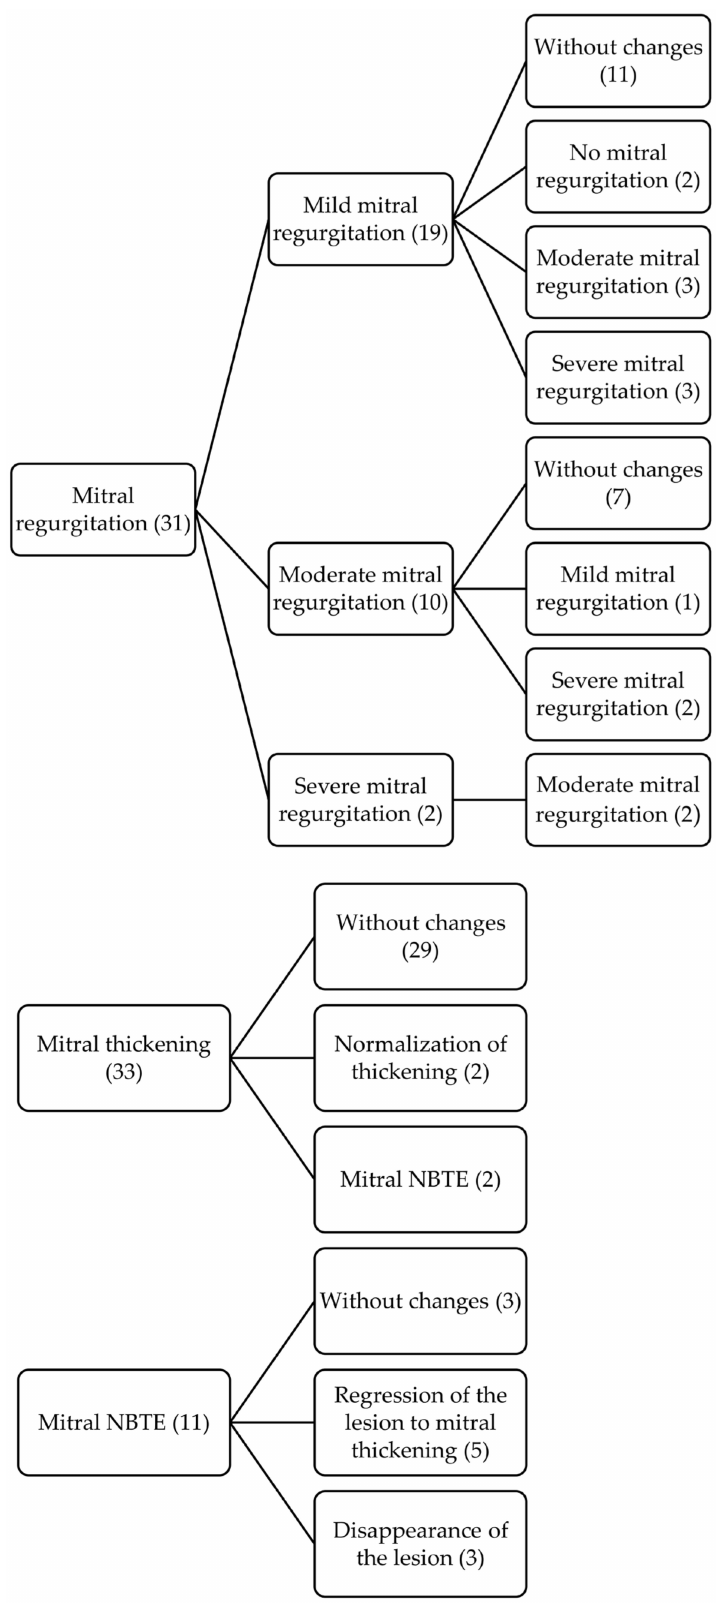
Figure 1. Timeline diagram with evolutive changes of mitral valve